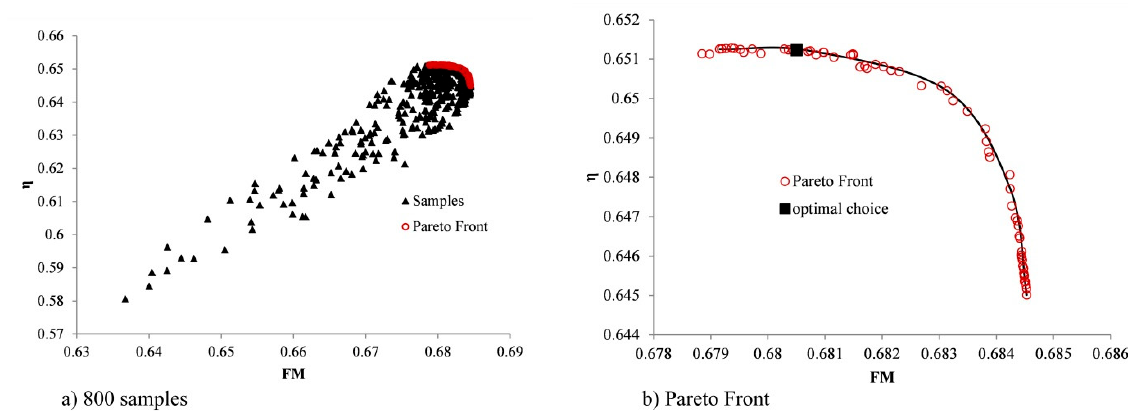
Figure 14. Multi-objective optimization results based on NSGA-II (20 generations).